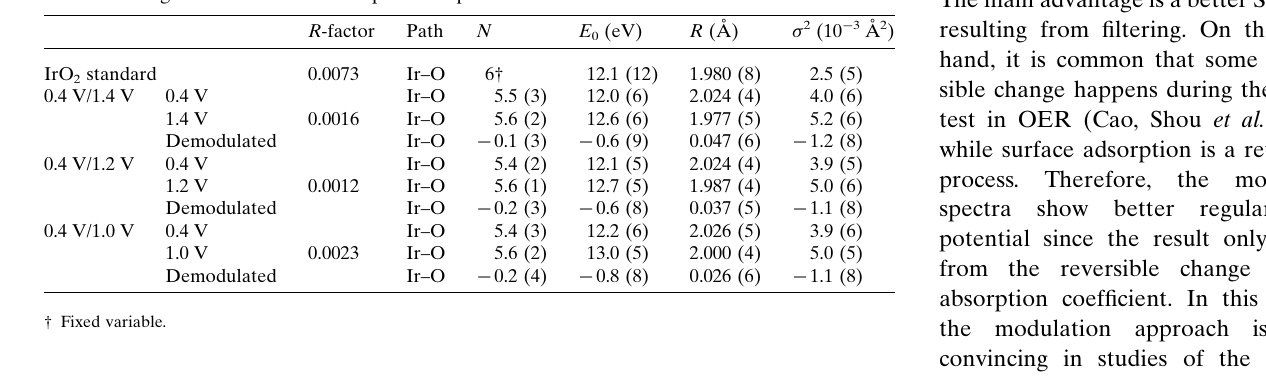
Table 1 EXAFS fitting results for different experiment parameters.